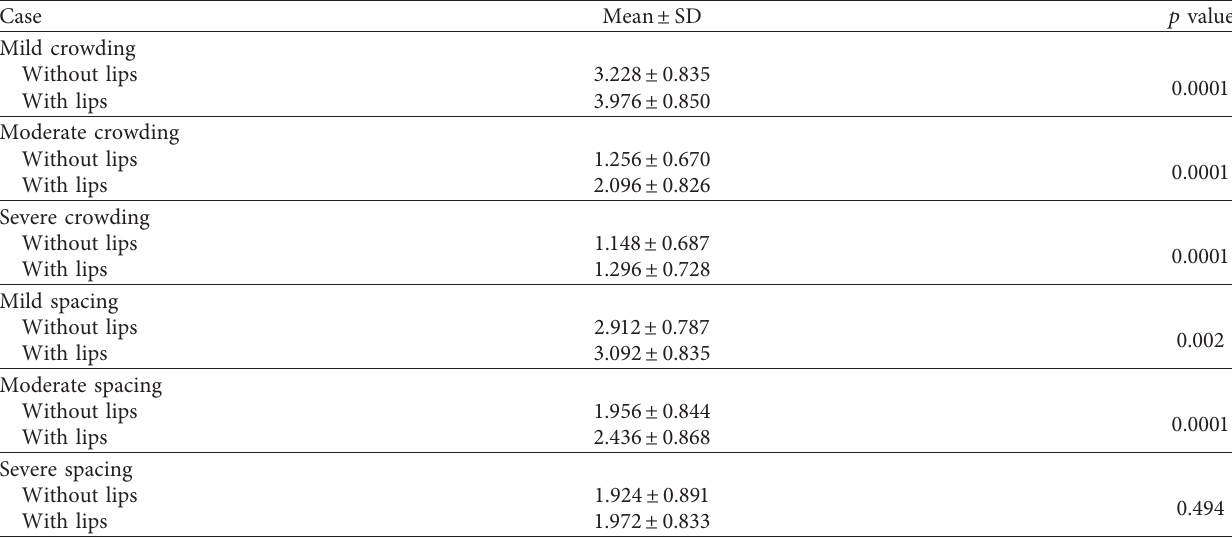
Table 1: Differences in the perception of attractiveness of anterior crowding and spacing with and without the lips. Case